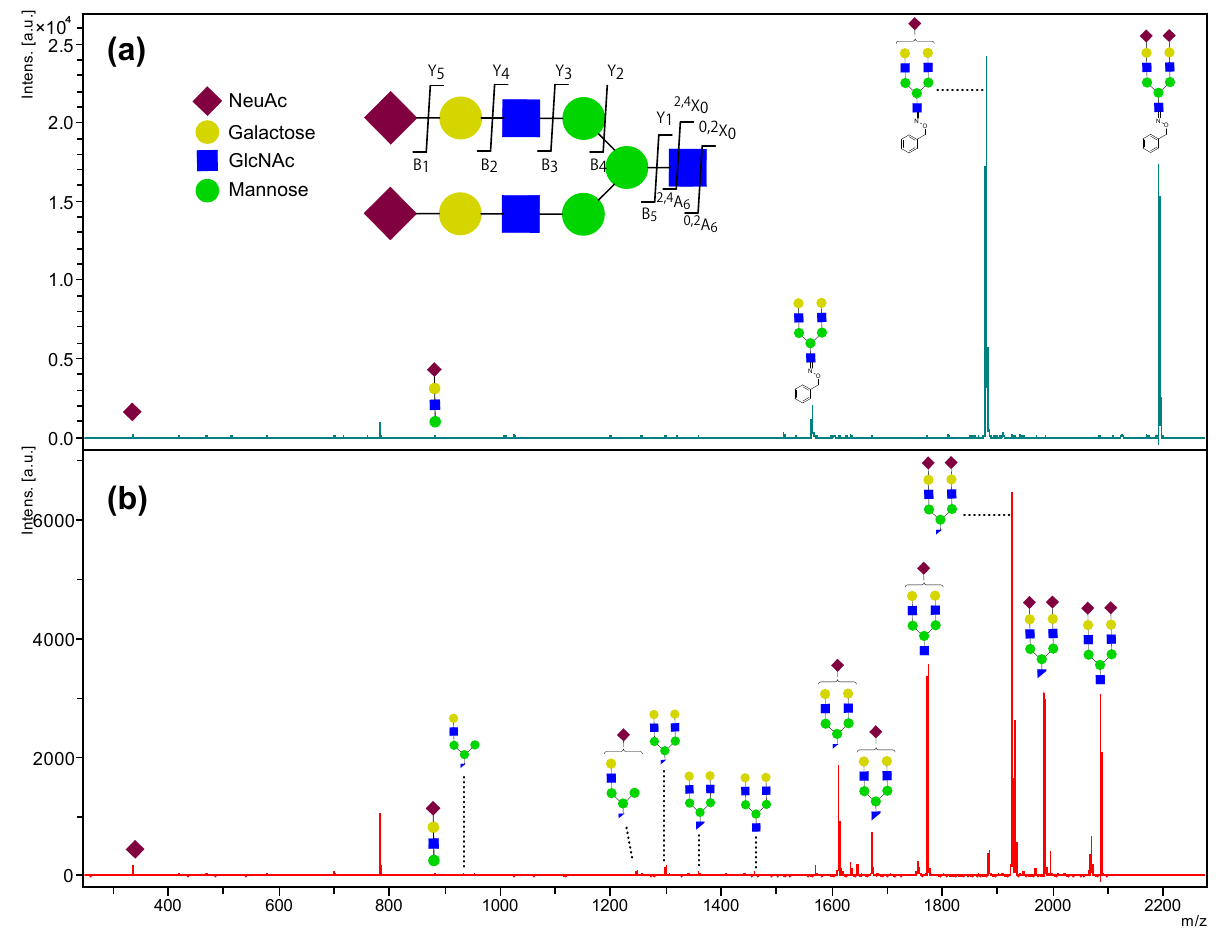
Figure 5. MALDI–TOF/TOFMS fragmentation patterns (parent mode, laser power 90%, 1200 shots, random walk mode) of the parent ions derived from SGP-10 (as sodium adduct ions) with different ma- trix systems spotted on AnchorChip TM MALDI target plates: ( a ) BOA/DHB/Na; ( b )